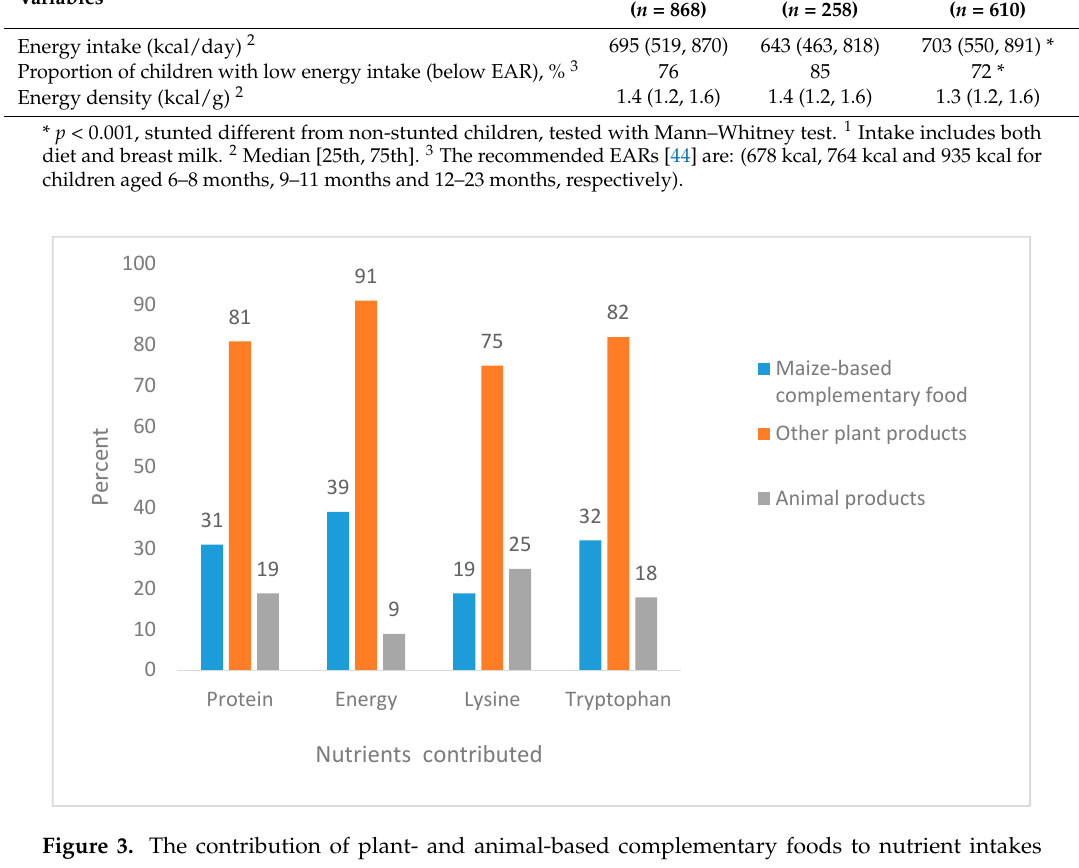
Table 5. Protein and inflammation biomarkers and intestinal parasites of children 1